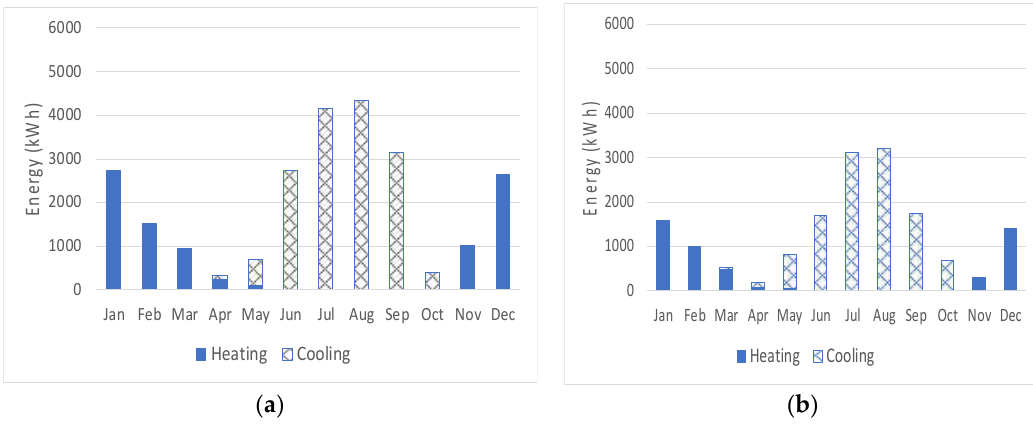
Figure 8. Heating and cooling energy demand for (a) Madrid and (b) Barcelona.